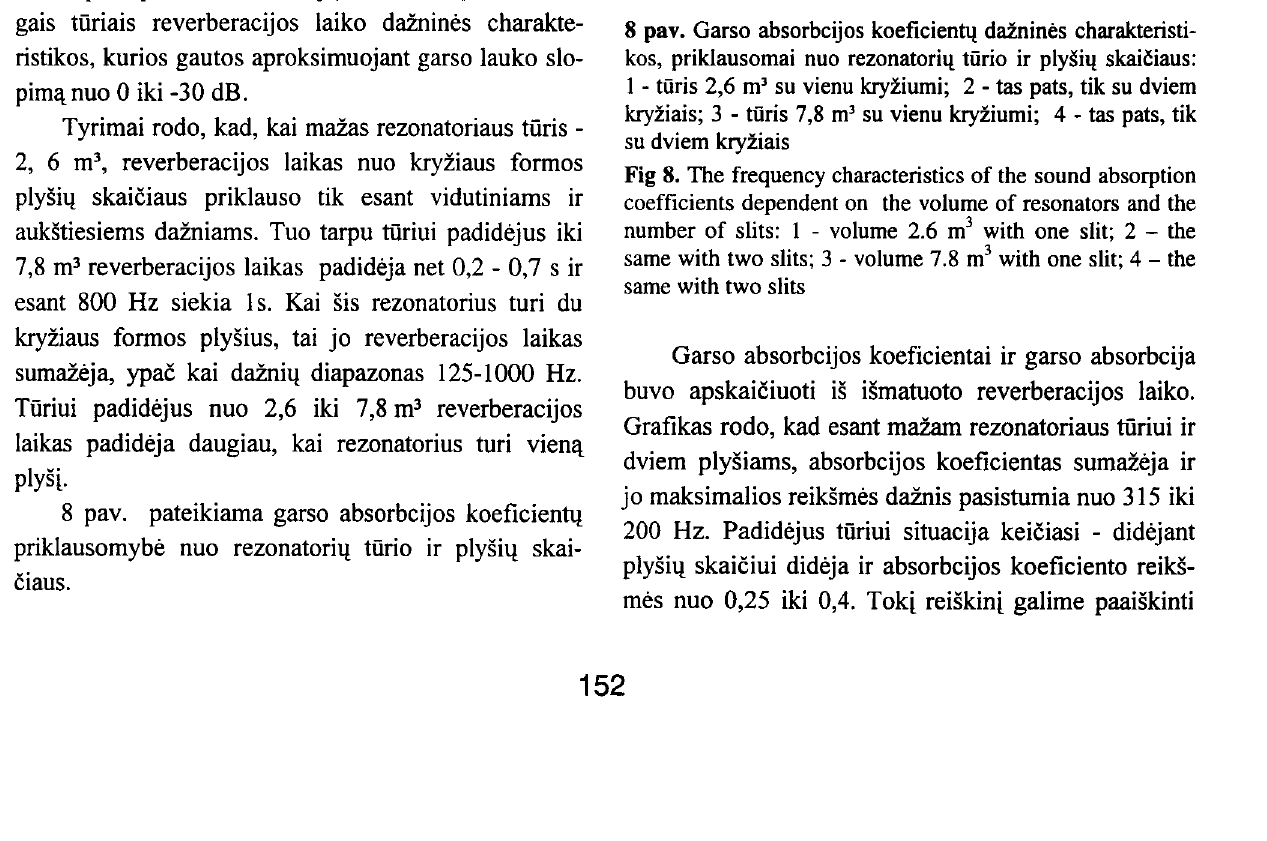
schemos ir jq matmenys; s - garso saltinis Fig 6. The layout of isolated cross-shaped resonators with the indication of dimensions; S - sound source